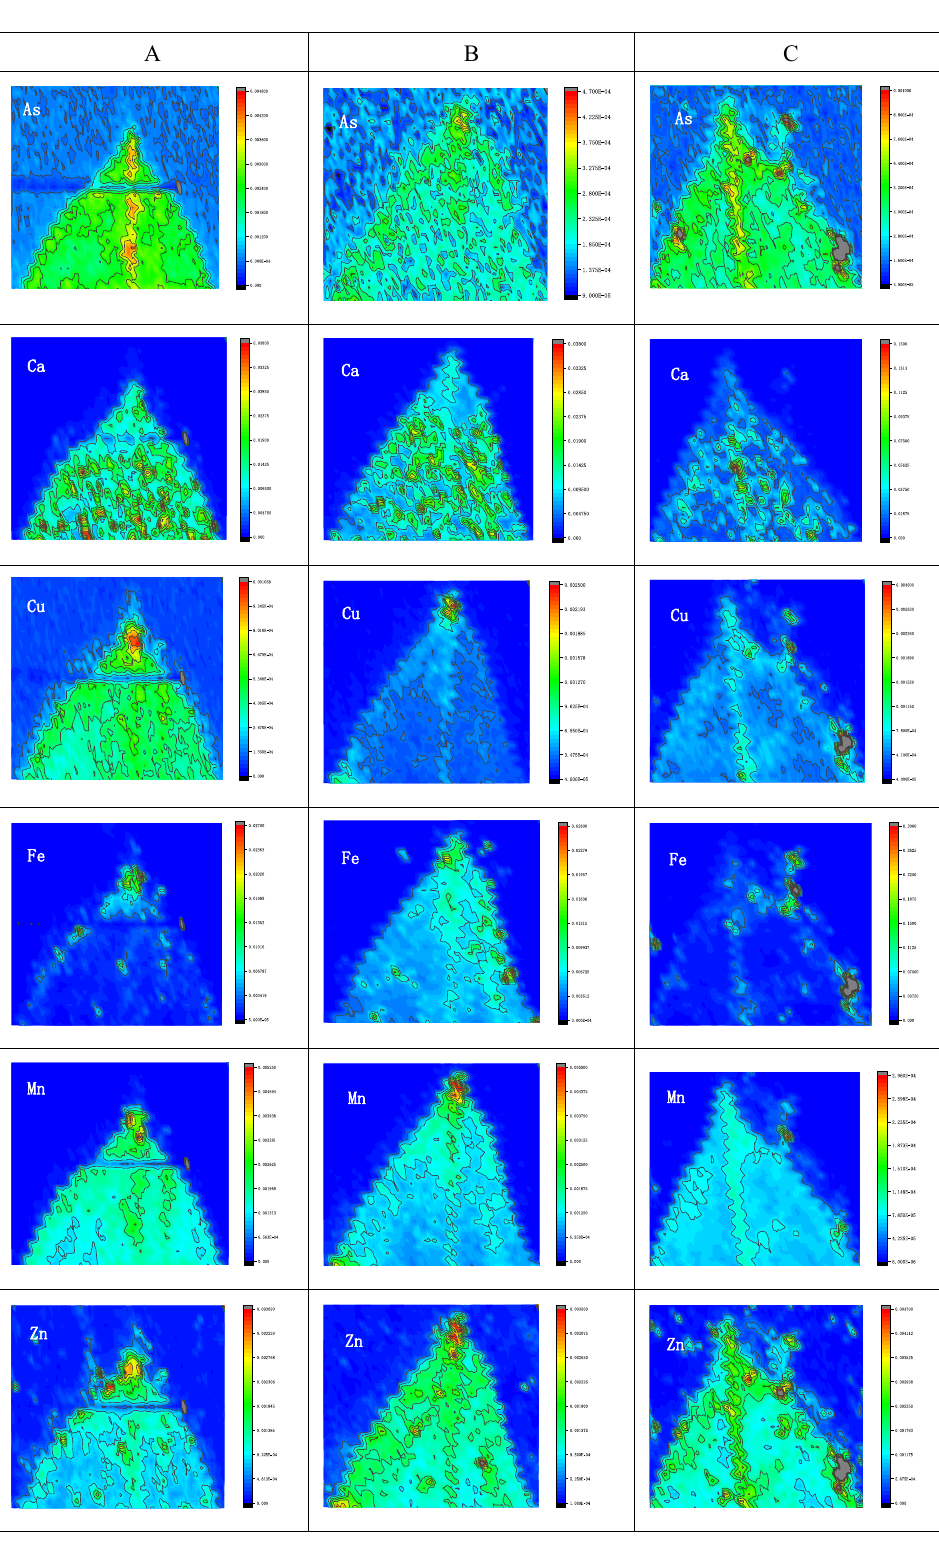
Figure 3: The μ - XRF distribution of As and other related elements in honeysuckle leaves. ( A ) 70 mg/L DMA group, ( B ) control group, and ( C ) 30 mg/L As ( III )